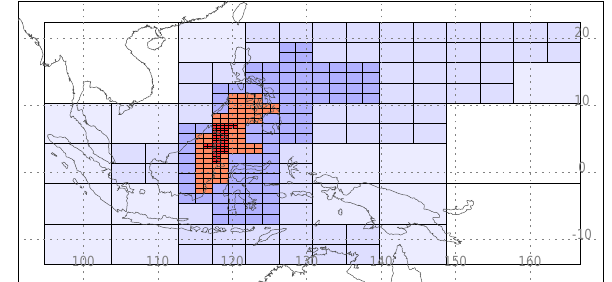
Fig. 3. The solution grid, which contains cells of various sizes, and Fig.3. Thesolutiongrid,whichcontainscellsofvarioussizes, andcoversthe sameareaasthe dilution grid(Fig.2). The‘fine’gridcells(ofsize1by1and2by2dilutiongridcells)arecolouredinred/orange. covers the same area as the dilution grid (Fig. 2). The “fine” grid cells (of size 1 by 1 and 2 by 2 dilution grid cells) are coloured in Fig. 2. The mean dilution matrix, averaged over backward trajec- Fig.2. Themean dilutionmatrix,averagedoverbackwardtrajectoriesreleased frombothmeasurement locations, and over all 3 hour periods for which observations are available at a particular measurement tories released from both measurement locations, and over all 3h location. The black cross marks the average of the two proximate measurement locations. The grid periods for which observations are available at a particular mea- covers ∼ 95–165 ◦ E, 13.5 ◦ S–22 ◦ N (128 by 96 grid cells). The units are s m − 1 and the colour scale is 35 logarithmic. The solid black contour encloses the ‘fine’ cells in the solution grid for which emission surement location. The black cross marks the average of the two estimatesaresubsequentlygiven. Thedottedblackboxhighlightstheregionplottedin Fig.5and6. proximate measurement locations. The grid covers ∼ 95–165 ◦ E, 13.5 ◦ S–22 ◦ N (128 by 96 grid cells). The units are sm − 1 and the 34 colour scale is logarithmic. The solid black contour encloses the “fine” cells in the solution grid for which emission estimates are subsequently given. The dotted black box highlights the region plot- ted in Fig. 5 and 6.